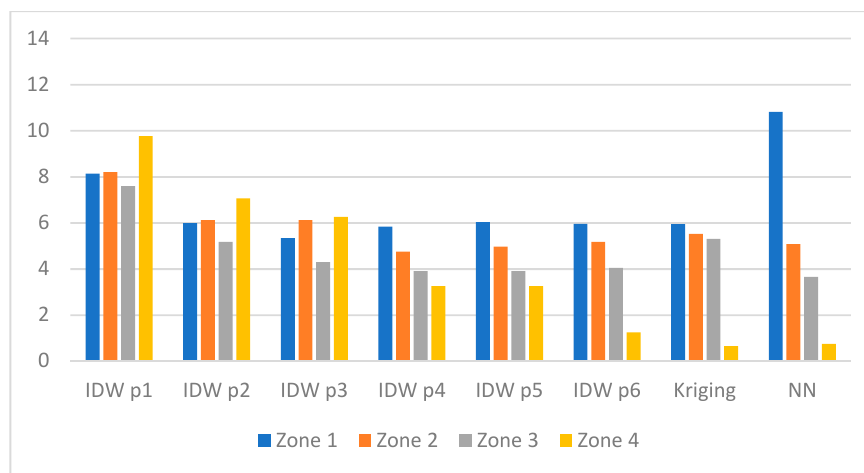
Figure 6. RMSE in zones (value in dB) for Test_20c.